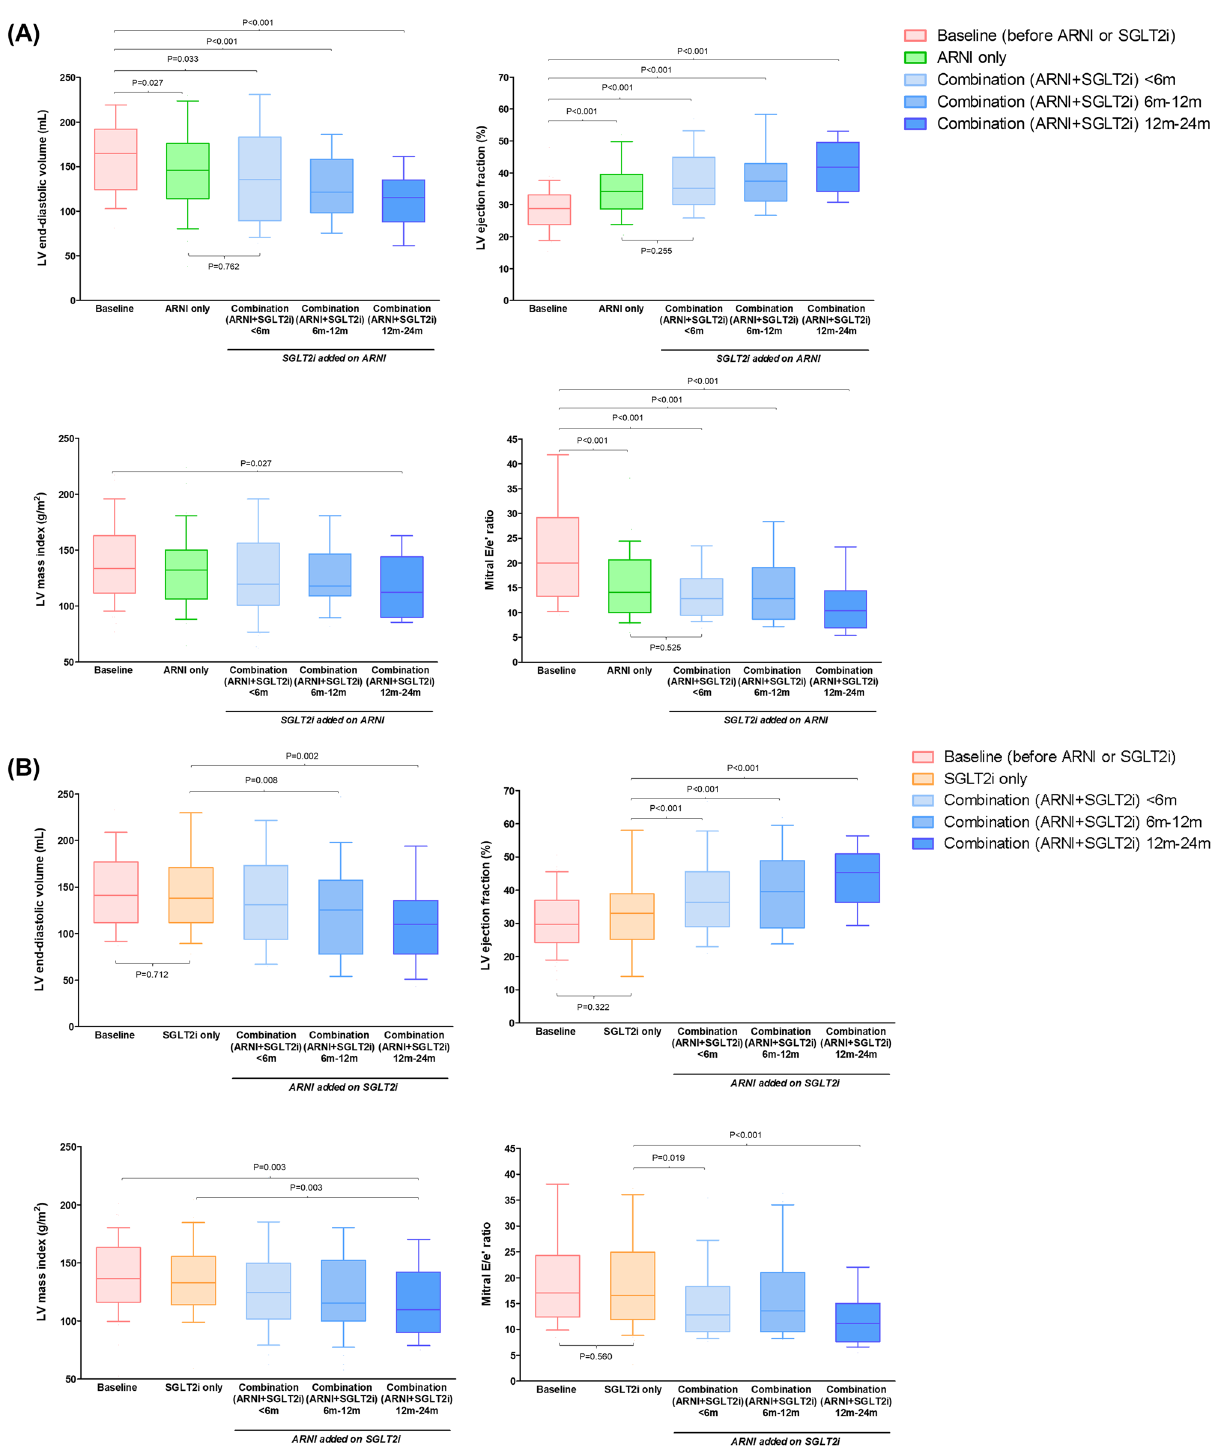
Figure 4. Changes in cardiac function based on the order initiation of ARNI and SGLT2i treatment. The serial measurements of LV ejection fraction, LV end-diastolic volume, LV mass index, and mitral E/e ′ ratio are plotted in ( A ) patients who initiated ARNI before SGLT2i, and ( B ) patients who initiated SGLT2i before